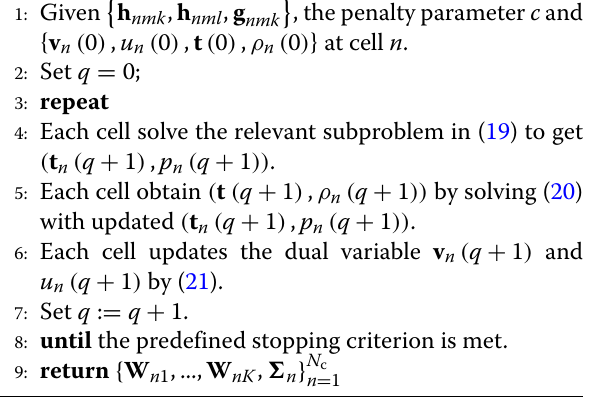
Algorithm 1 Distributed algorithm with